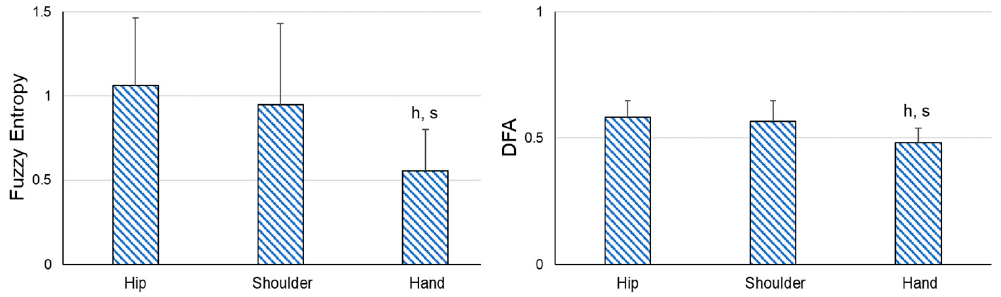
Figure 3. Pairwise comparisons between the different sensors in the static and relaxed situations. DFA = detrended fluctuation analysis. h = significant differences compared to the hip sensor; s = significant differences compared to the shoulder sensor. p ≤ 0.001.